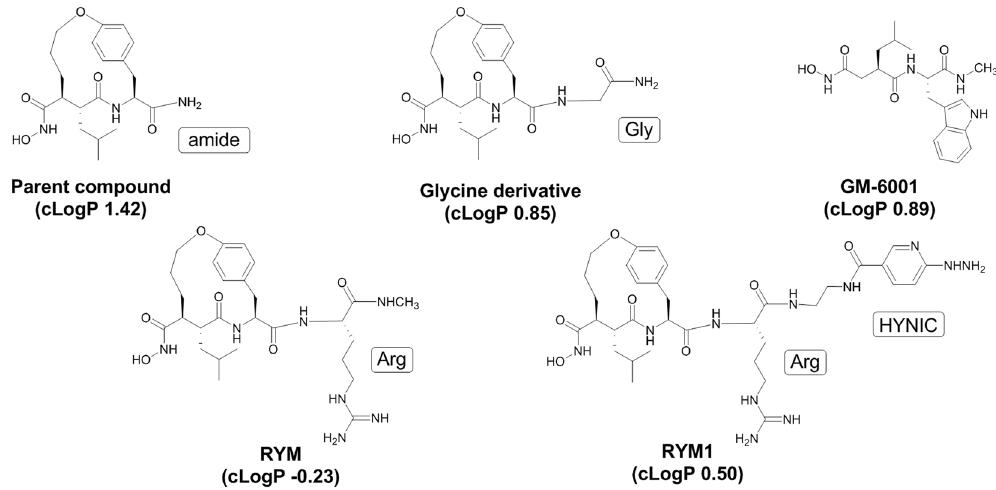
Figure 10. Chemical structures and cLogP values of hydroxamate-based MMP